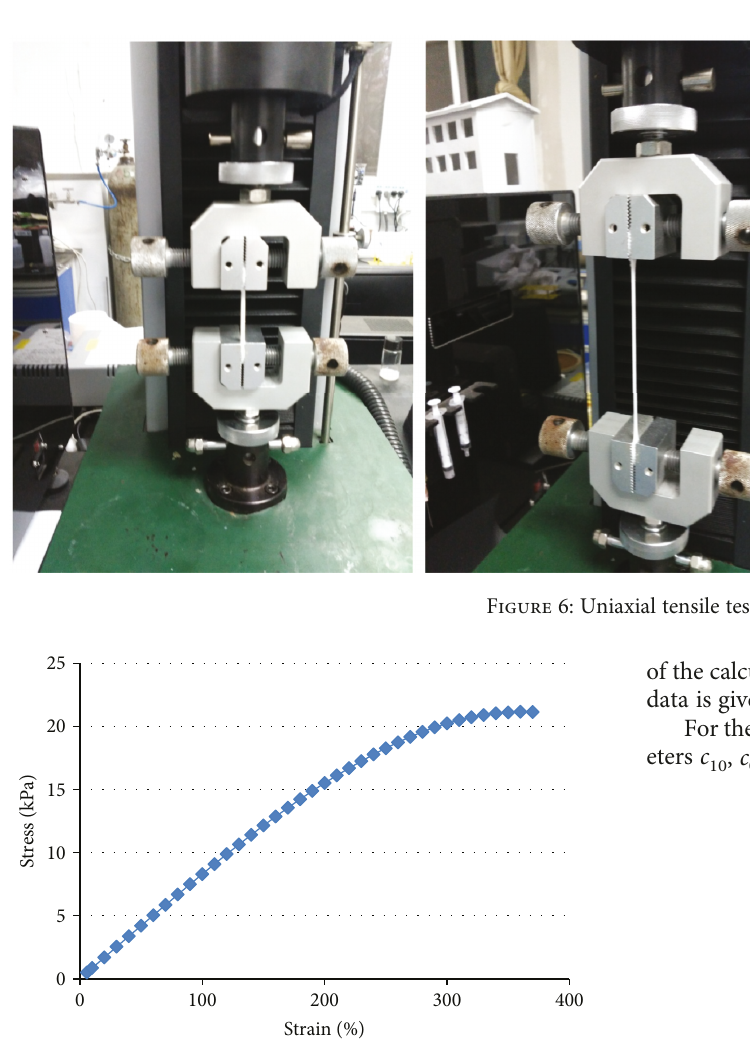
Figure 7: Stress-strain curve of the ionic liquid gel